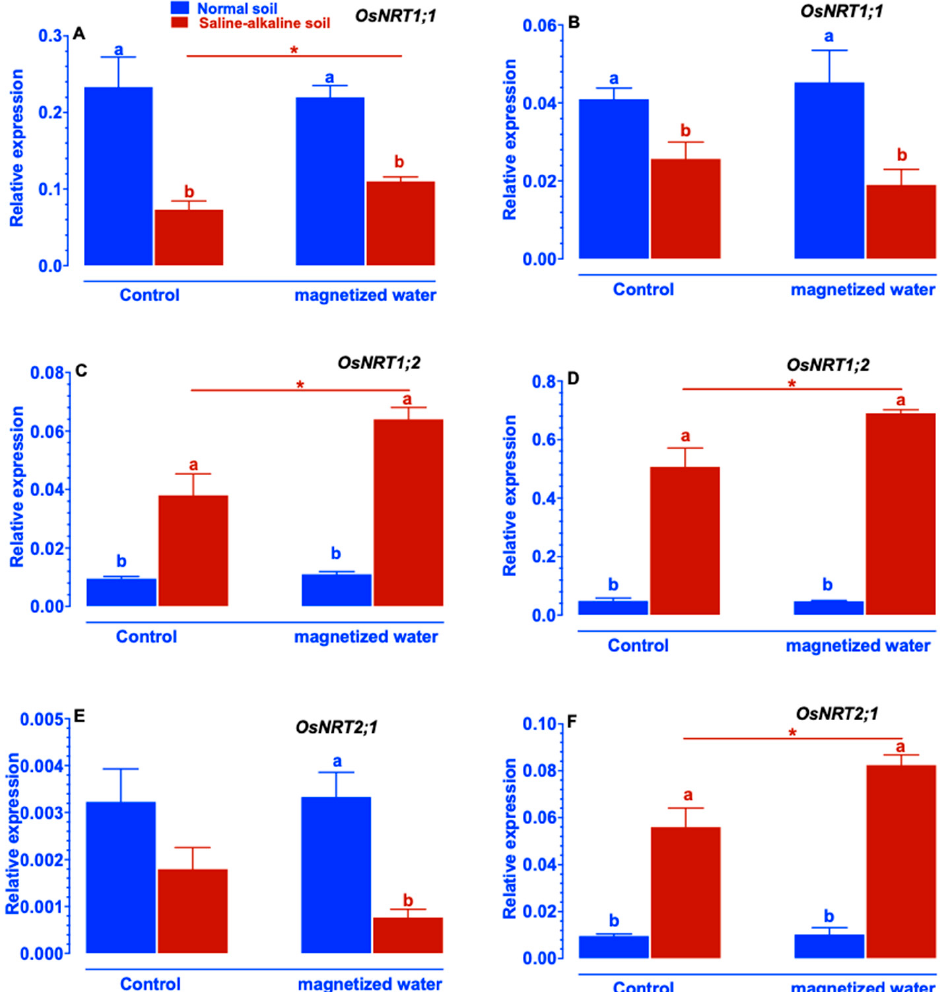
Figure 5. Effects of magnetized water on the expression of the OsNRT gene family in Nipponbare seedlings grown in normal and saline–alkaline stress soil: ( A ) OsNRT1;1 in shoot, ( B ) OsNRT1;1 in root, ( C ) OsNRT1;2 in shoot, ( D ) OsNRT1;2 in root, ( E ) OsNRT1;3 in shoot, ( F ) OsNRT1;3 in root. Treatments were as described in Figure 1. Means with different letters are significantly different ( p < 0.05) within the same treatment. Asterisks indicate significant differences between control and saline–alkaline stress of the same genotype, as determined by Student’s t -test (* p < 0.05). Expression levels of OsAMT1;1 and OsAMT1;3 in Nipponbare plants were unaffected by exposure to magnetized water (Figure 6A,B,E,F). Magnetized water irrigation